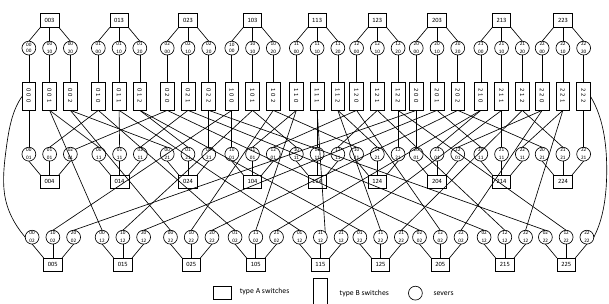
Figure 2. Structure of BCCC(3,2).